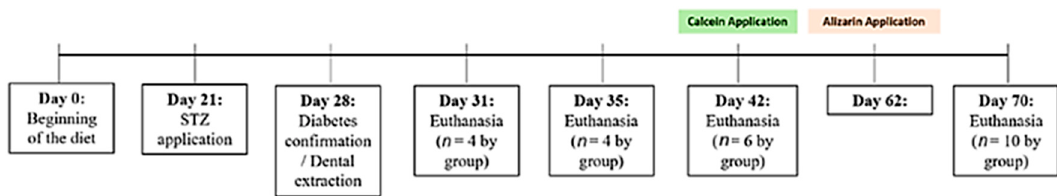
Figure 1. Experimental model timeline. Beginning of the diet = day 0; STZ application = day 21; Diabetes confirmation/dental extraction = day 28; Fluorochromes application = days 42 and 62;